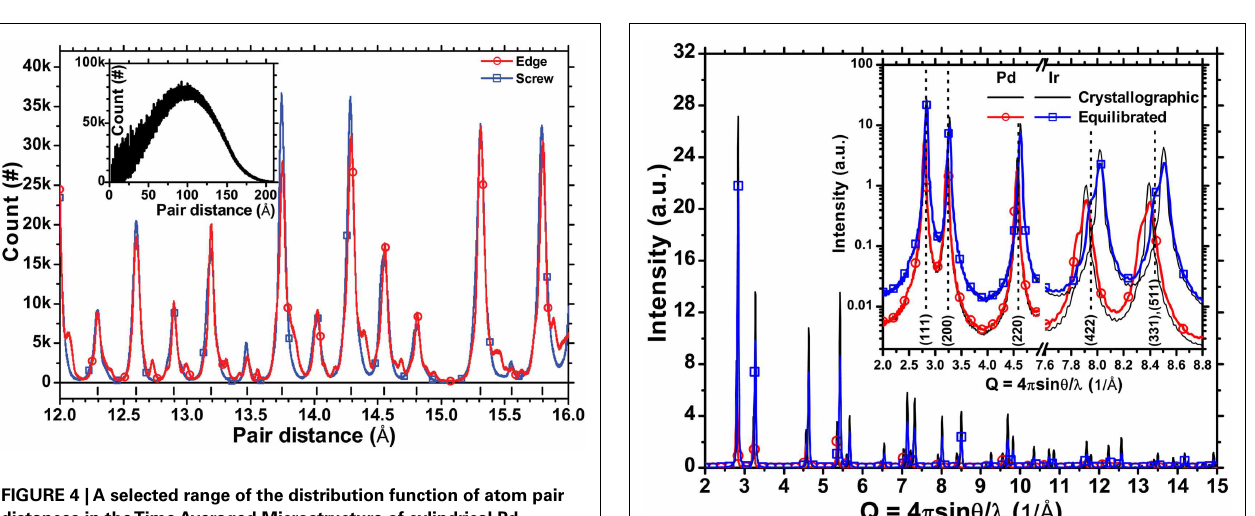
FIGURE 4 |A selected range of the distribution function of atom pair distances in theTimeAveraged Microstructure of cylindrical Pd nanocrystals ( D = H = 16nm) with edge (red circular dot) and screw (blue square dot) dislocation lines .The inset shows the trend across the whole range of distances.